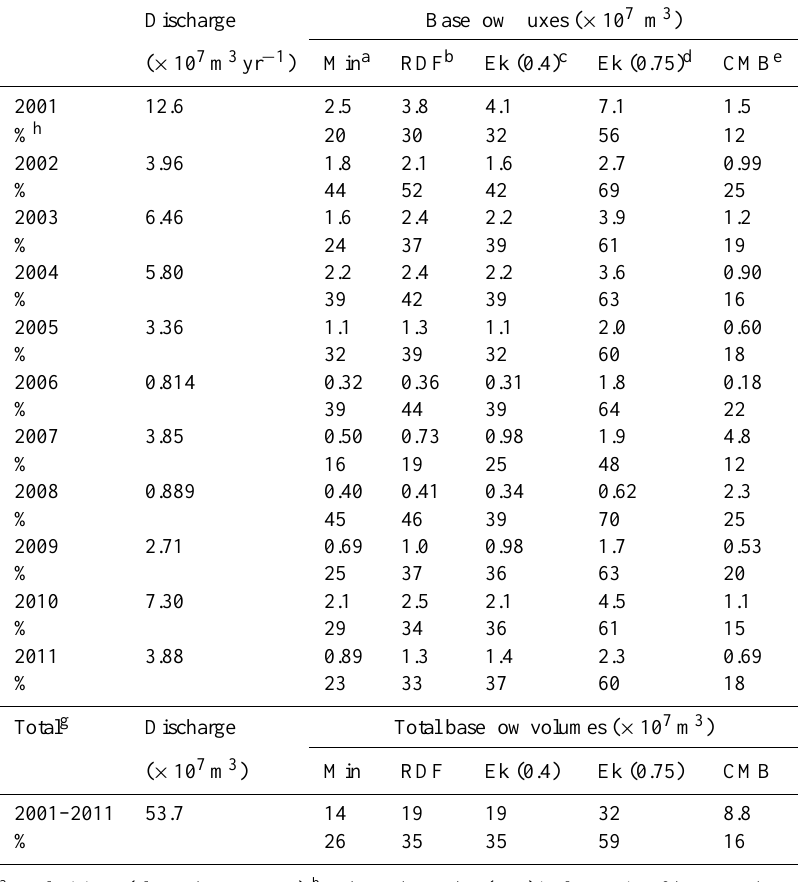
Table 1. Summary of baseflow estimates for the upper Barwon River.